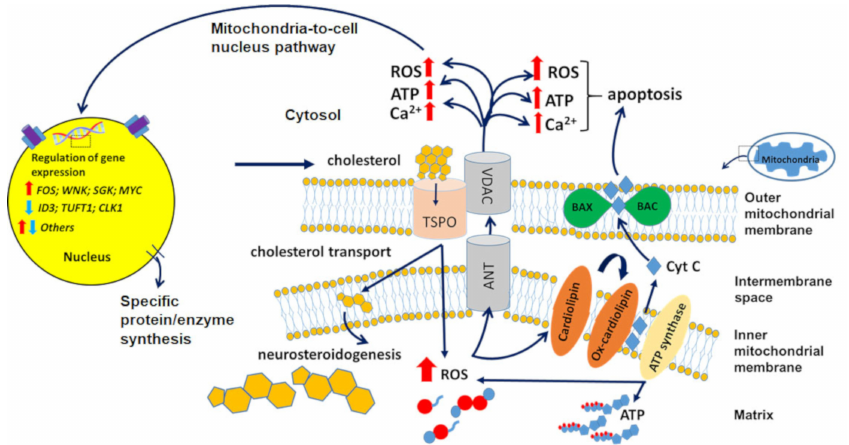
Figure 1. Principal functions of the 18-kDa translocator protein (TSPO): initiation of programmed cell death, includingapoptosis, aswellasregulationofthecell’snucleargeneexpression.